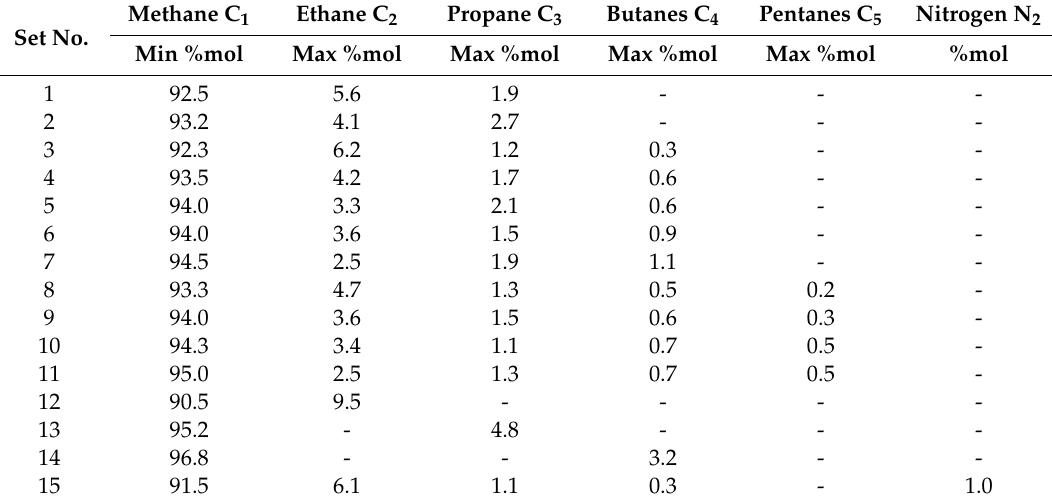
Figure 8. Methane number as function of methane and other components molar fraction for LNG composition set 7. Table 6. Limit contents of methane and other components for methane number equal to 80. Set No.